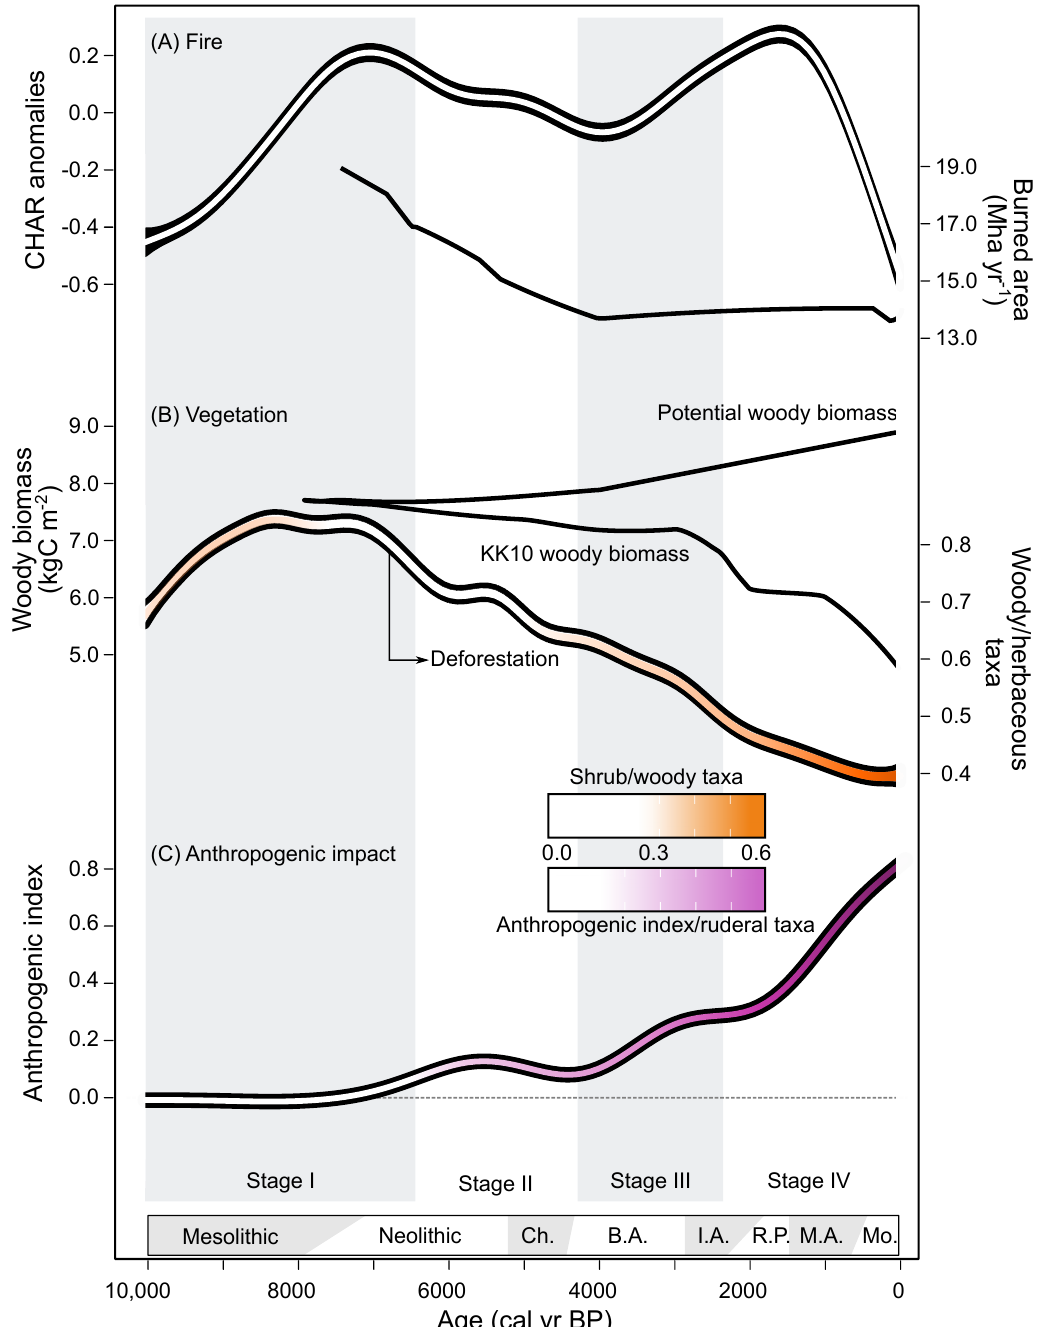
Figure 2. Holocene trends in fire, vegetation and anthropogenic impact in the Western Mediterranean and Adjacent Atlantic Regions (WMAAR). ( A ) Regional biomass burning, as estimated by a Generalized Additive Model (GAM) applied to the charcoal data from the entire Western Mediterranean and Adjacent Atlantic Regions (this study), and modeled area burned [5]. ( B ) Vegetation openness inferred from modeled potential woody biomass [5], biomass under the KK10 scenario [25] and regional woody-to-herbaceous pollen taxa (this study). The relative proportion of shrubs-to-woody taxa pollen is shown in orange. The arrow indicates the onset of pronounced forest loss identified through the Cross-Entropy method for break-point detection. ( C ) Anthropogenic index as a function of time (this study). The pink shading represents the total anthropogenic index-to-ruderal taxa ratio. In all cases, the black shading depicts 95% confidence intervals for the estimated